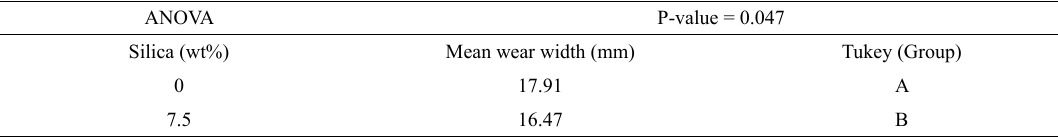
Table 4. Abrasion test results (Tukey test).